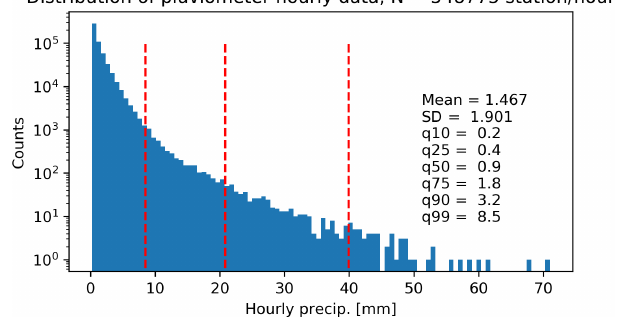
Figure 2. Distribution and statistical indicators of hourly observed precipitation intensities for the entire database (January 2016 to De- cember 2019). The three vertical dashed red bars indicate the per- centiles 99, 99.9 and